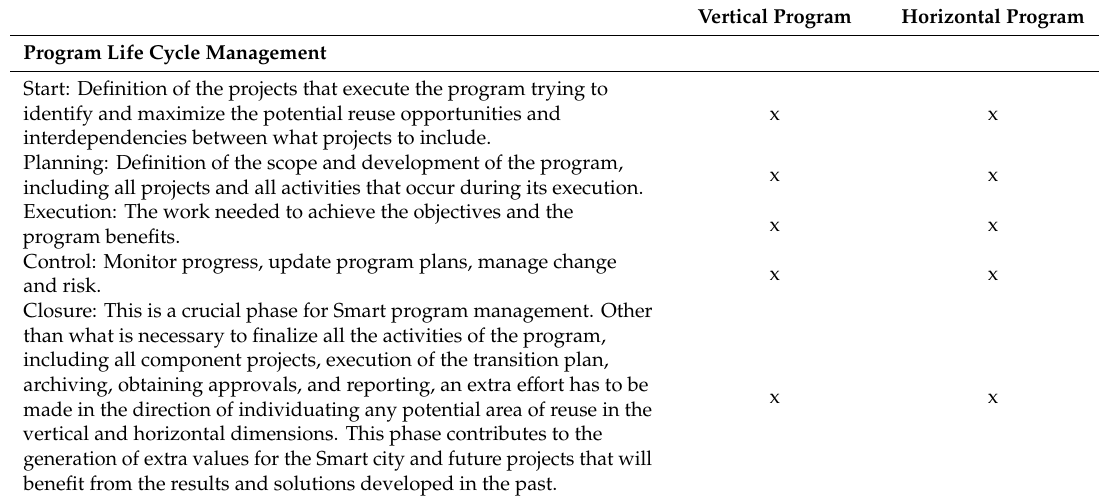
Table 1. Program life cycle management: vertical and horizontal